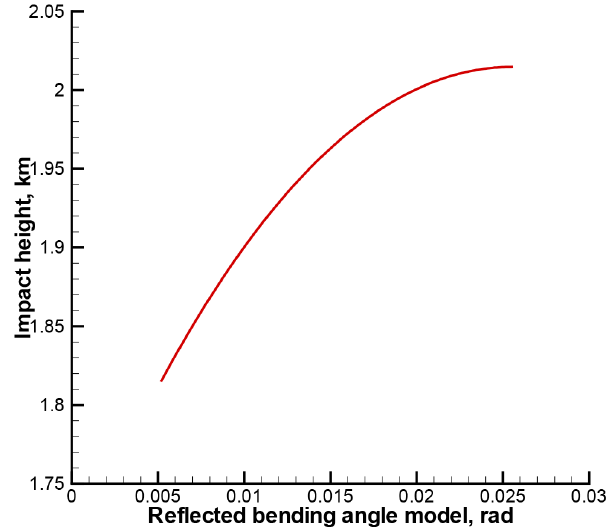
Figure 6. Reflected bending angle model for occultation event 1 January 2008, 01:02:23UTC, 70.28 ◦ N 121.87 ◦ W (the same event as in Fig.